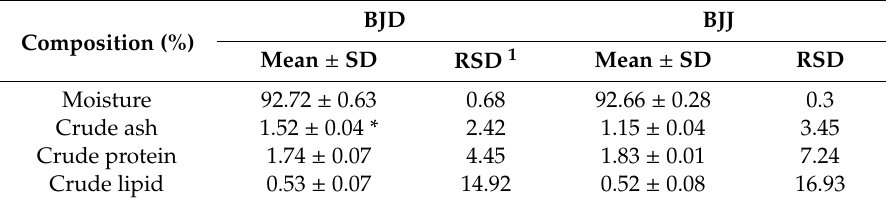
Table 3. Comparison of proximate composition of BJD and